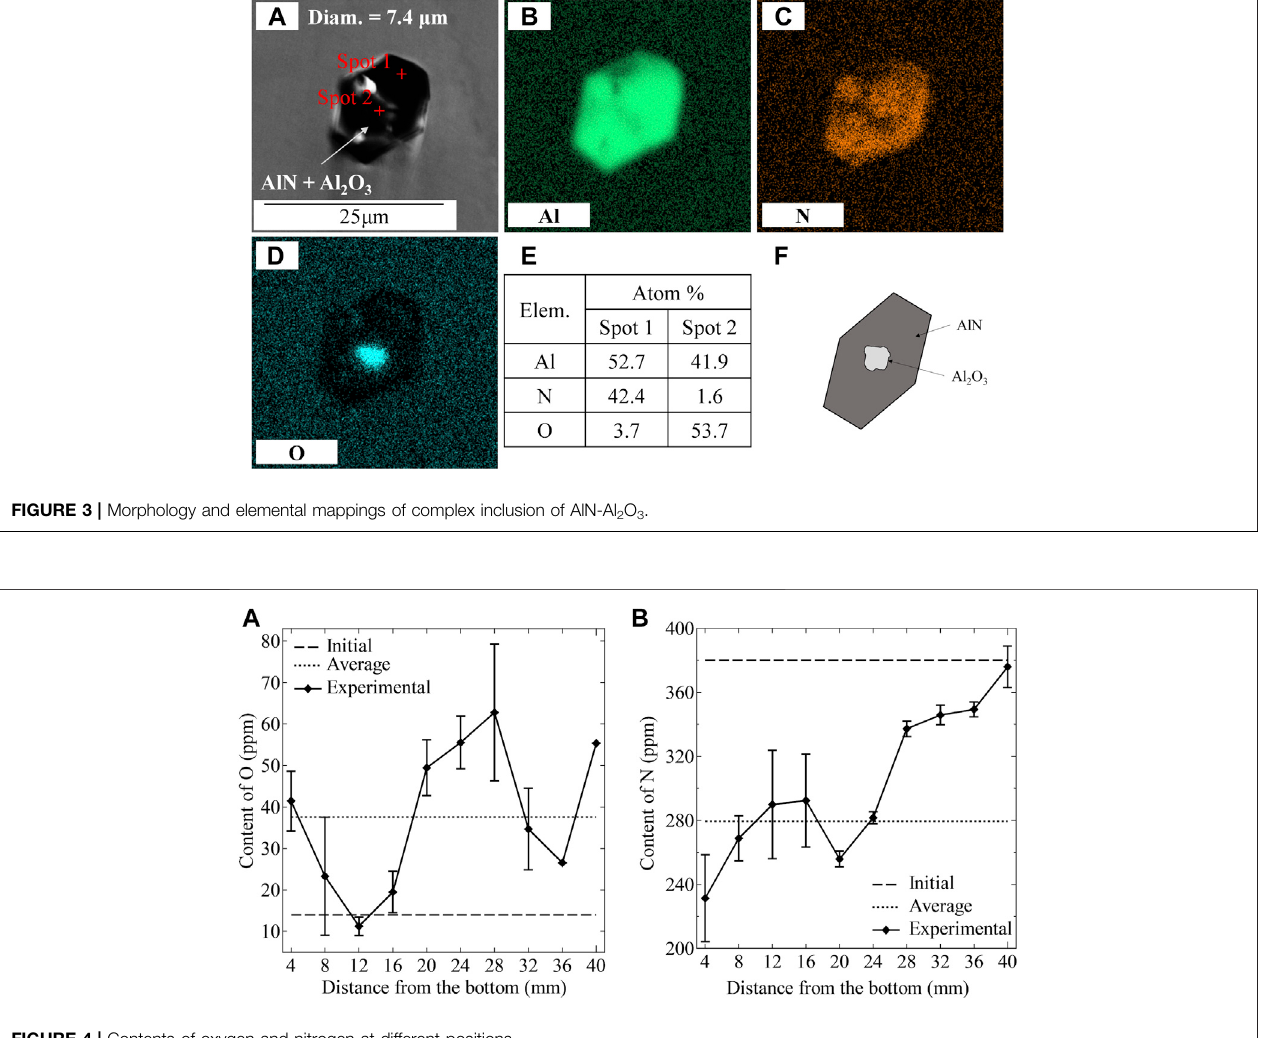
FIGURE 4 | Contents of oxygen and nitrogen at different